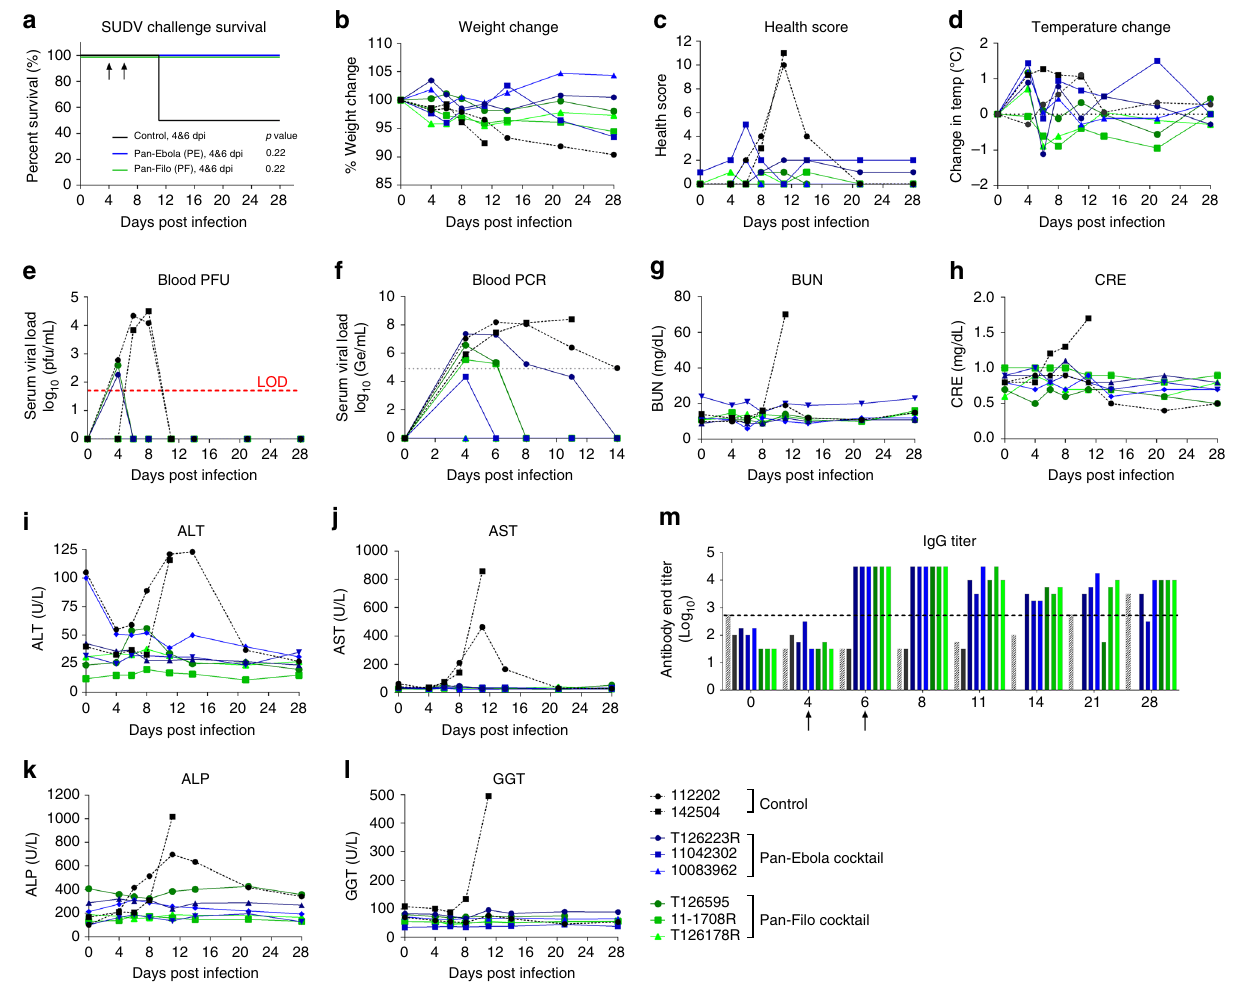
Fig. 3 Ef fi cacy of PE and PF cocktails against SUDV infection. Rhesus macaques were infected with SUDV and treated with PE ( n = 3) or PF ( n = 3) cocktails at 4 and 6 dpi. Survival ( a ), daily health evaluations ( b – d ), viremia by plaque assay (limit of detect of 50 pfu/mL) ( e ) and RT-qPCR ( f ),